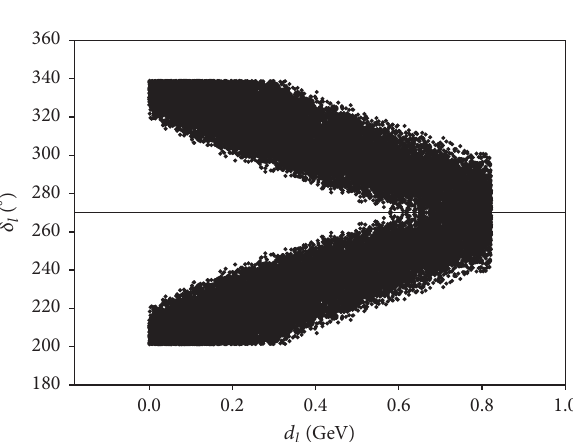
Figure 4: 𝑠 2 13 versus 𝑑 ] for Case